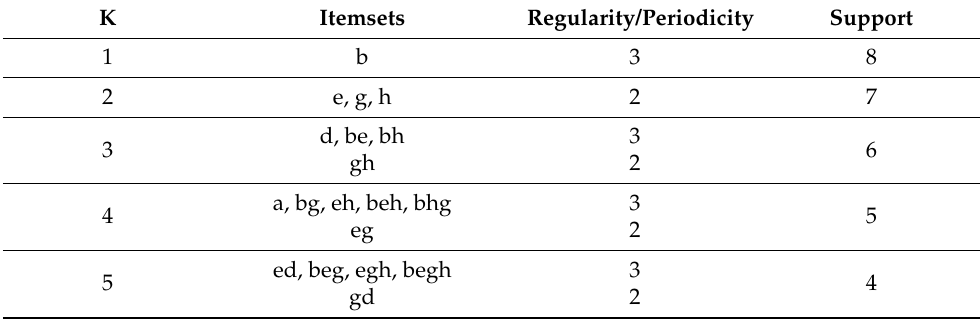
Table 5. Top-5 IFR set after mining batch A.